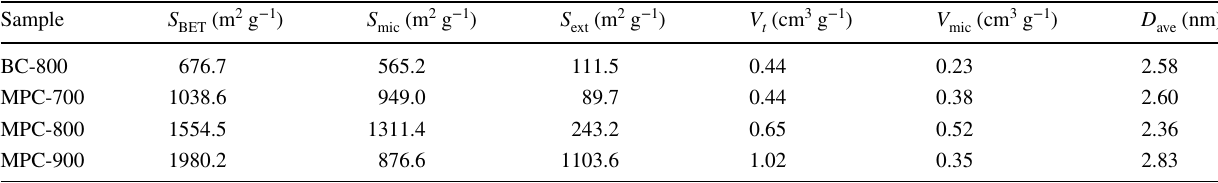
Table 1 Characterization of pores and specific capacitance of MPC series